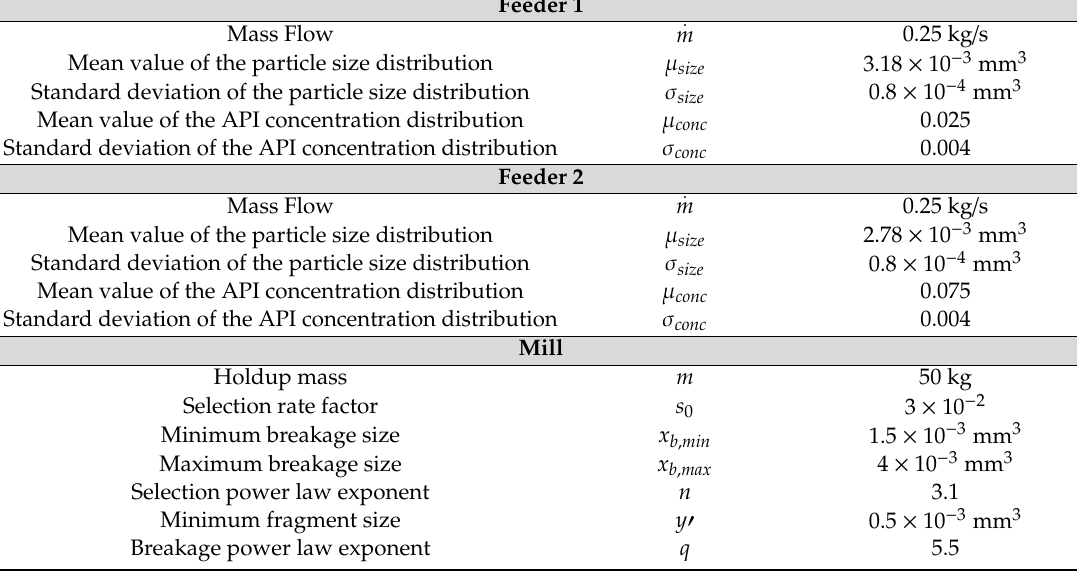
Figure 10. Simulation results of the breakage process.